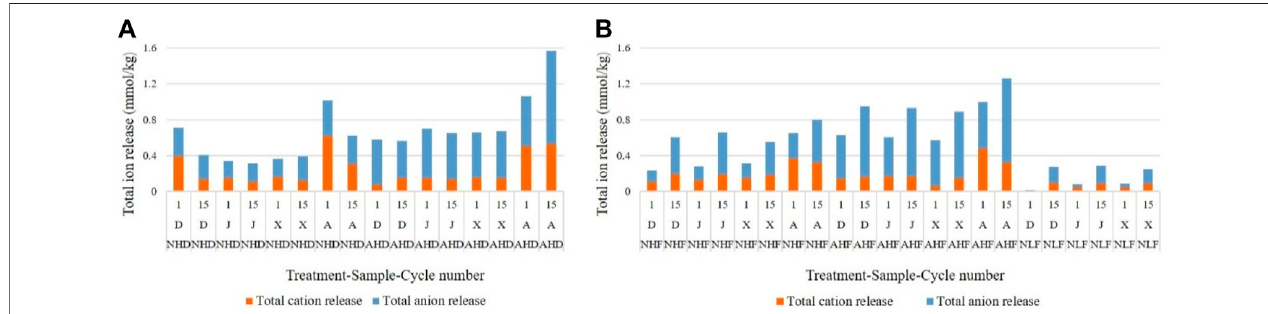
FIGURE 7 | Relation of leached cations and anions under (A) drying temperature treatments and (B) freezing temperature treatments. Codes of treatments are N — naturalrainandA — acidrain;H — highintensityandL — lowintensity;D — dryingtemperatureandF — freezingtemperature;DsamplefromDatangbadlands,China;J